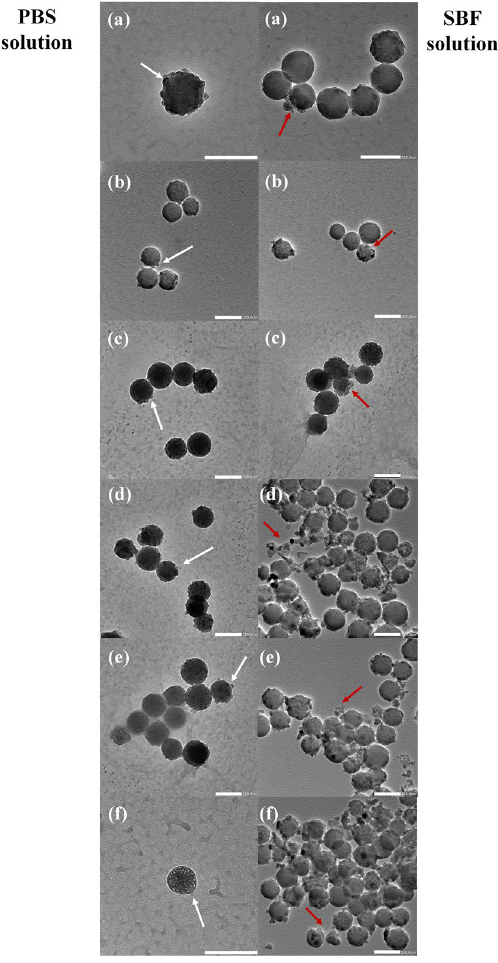
Figure 6. TEM micrographs of ( a ) 0Ag–0Zn-BGNPs, ( b ) 0Ag–1Zn-BGNPs, ( c ) 0.5Ag–1Zn-BGNPs, ( d ) 1Ag–1Zn-BGNPs, ( e ) 1.5Ag–1Zn-BGNPs, and ( f ) 1.5Ag–1.5Zn-BGNPs after incubation in the PBS solution (Left panel) and the SBF solution (Right panel) for 21 days. White arrows indicated the formation of salt on the particle surface in the PBS solution. Red arrows indicated the degraded particles and the apatite formation in the SBF solution. Scale bar: 200